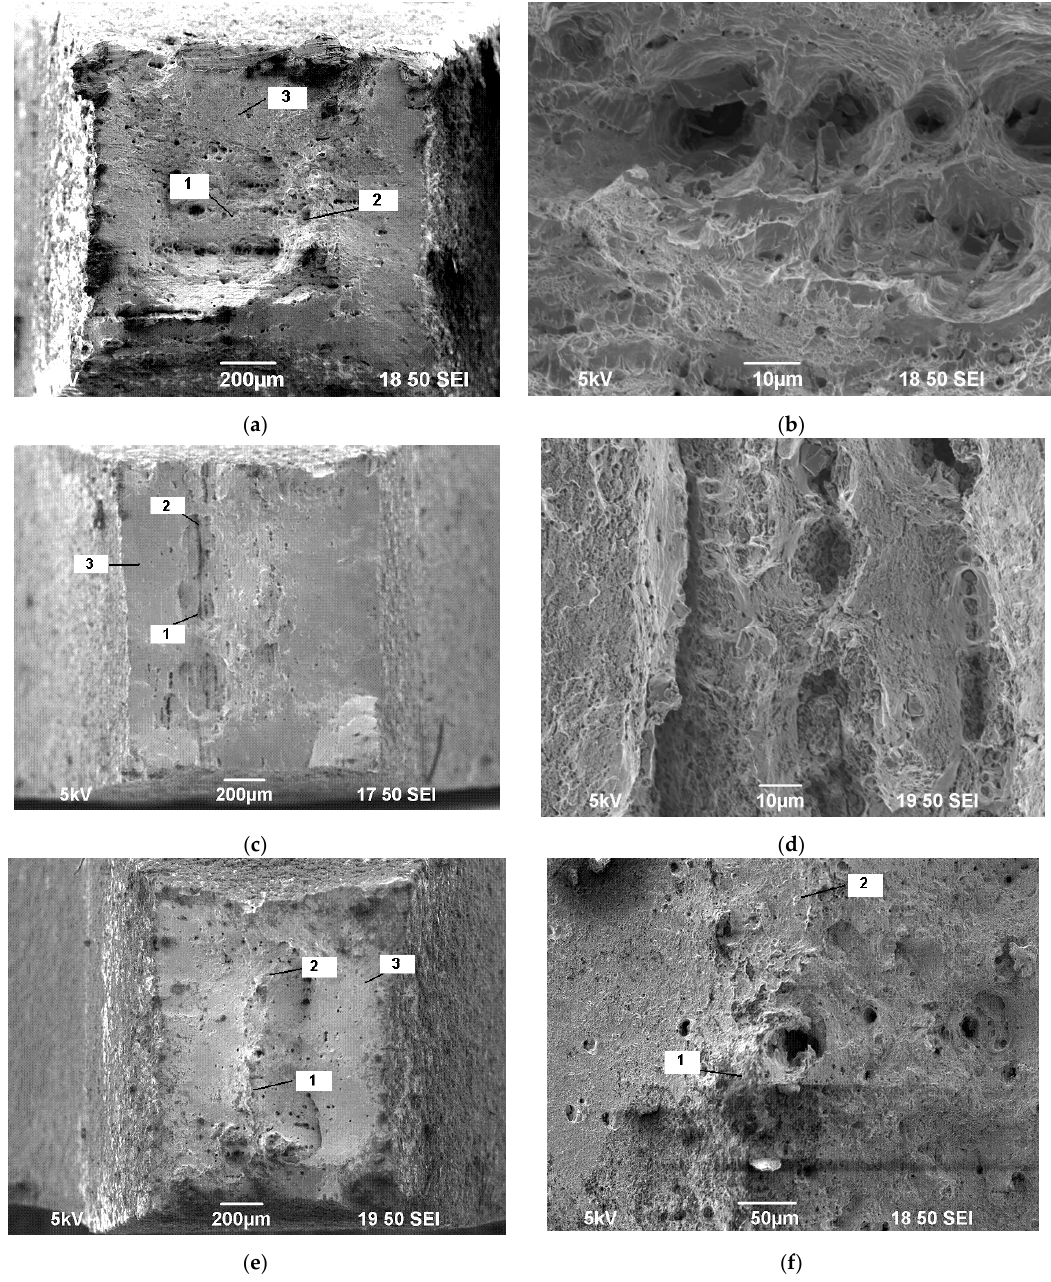
Figure 11. Fractographic analysis of fractures of steel specimens after tension tests at RT: ( a , b ) coarse-grained steel, ( c , d ) UFG steel (N = 4, Т ECAP = 150 ° С ), ( e , f ) UFG steel (N = 4, Т ECAP = 450 ° С ). Figs 11 a , b : Zone 1—a fibrous fracture zone; Zone 2—a radial zone; Zone 3—a cut zone; Fig. 11 d : a fibrous zone consisting of a set of pits and featuring viscous fracture.